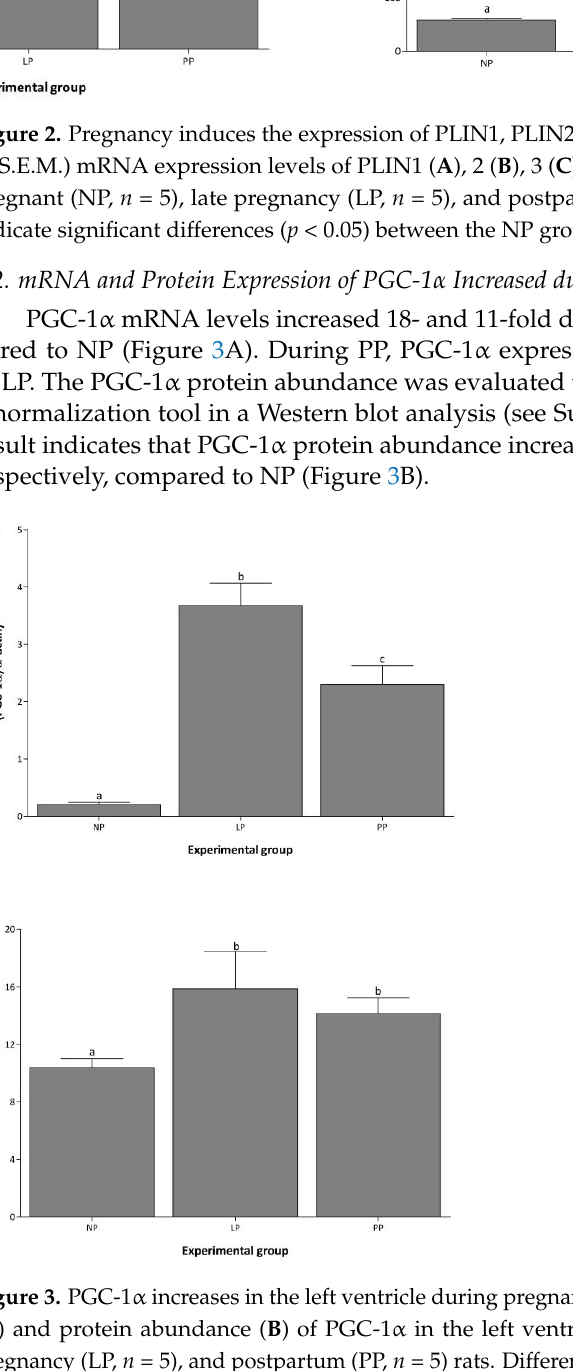
( p < 0.05) between the NP group and the LP and PP